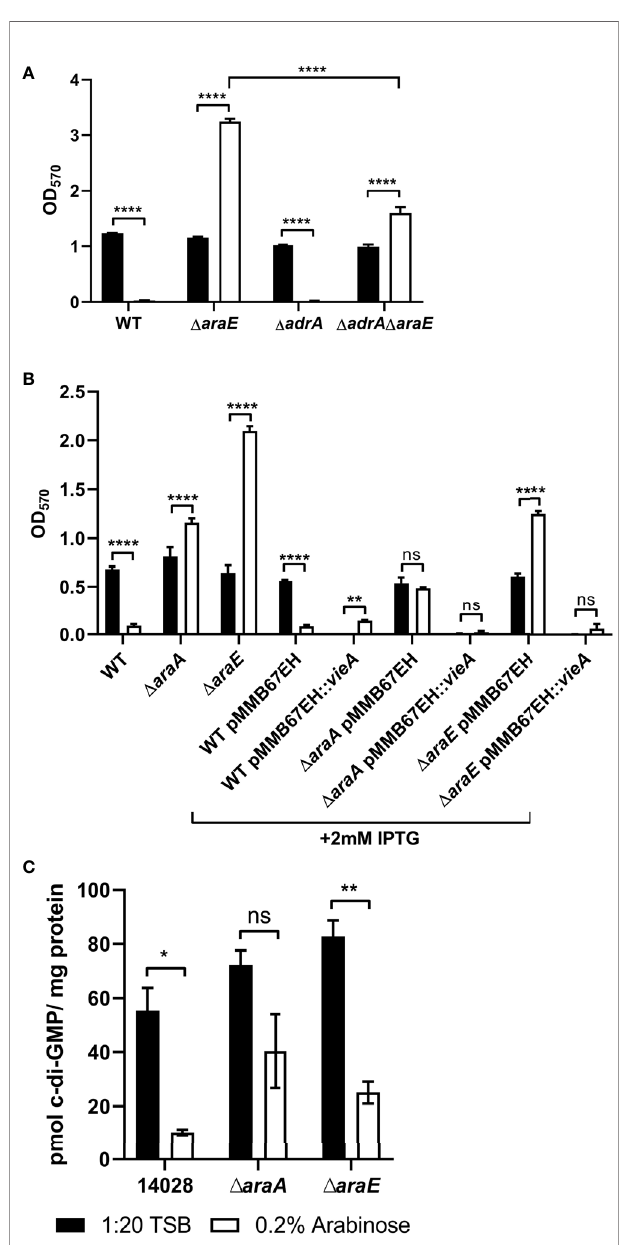
FIGURE 7 | C-di-GMP levels are involved in L-arabinose mediated bio fi lm formation. WT, D adrA , D araE (A) , or strains containing vieA expressed on a plasmid induced by IPTG (B) were grown in 96-well plates in 100 µL 1:20 TSB (black bars) or 1:20 TSB with 0.2% (white bars). After 24 hours, planktonic cells were removed, then bio fi lms were washed, heat fi xed, and stained with crystal violet (CV) for relative bio fi lm measurement as determined at OD 570 . (C) C-di-GMP was extracted from 24 hour bio fi lms grown in 1:20 TSB (black bars) or 1:20 TSB with 0.2% L-arabinose (white bars) and normalized to total protein concentration. Data are mean ± SD, statistical analyses were done using a two-way ANOVA with Dunnett ’ s multiple comparisons test NS, not signi fi cant ( P > 0.05); * P < 0.05; ** P < 0.01; **** P <